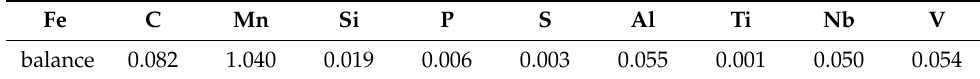
Table 1. Chemical composition of S460MC in wt.%.